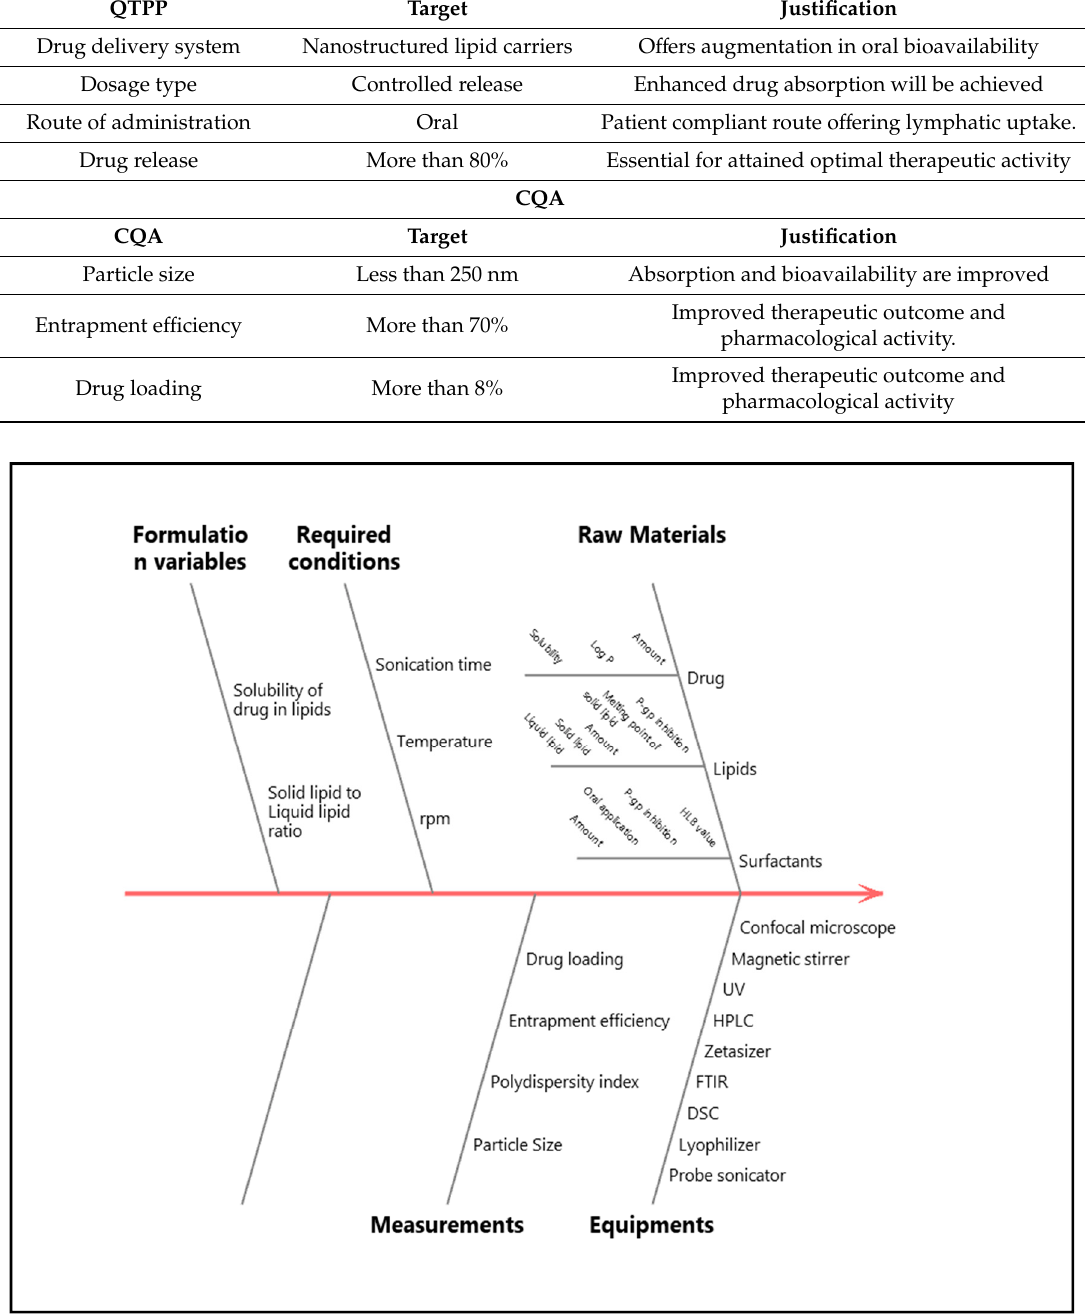
Figure 1. Ishikawa diagram for fabrication of atazanavir-nanostructured lipid carrier (ATZ-NLC).